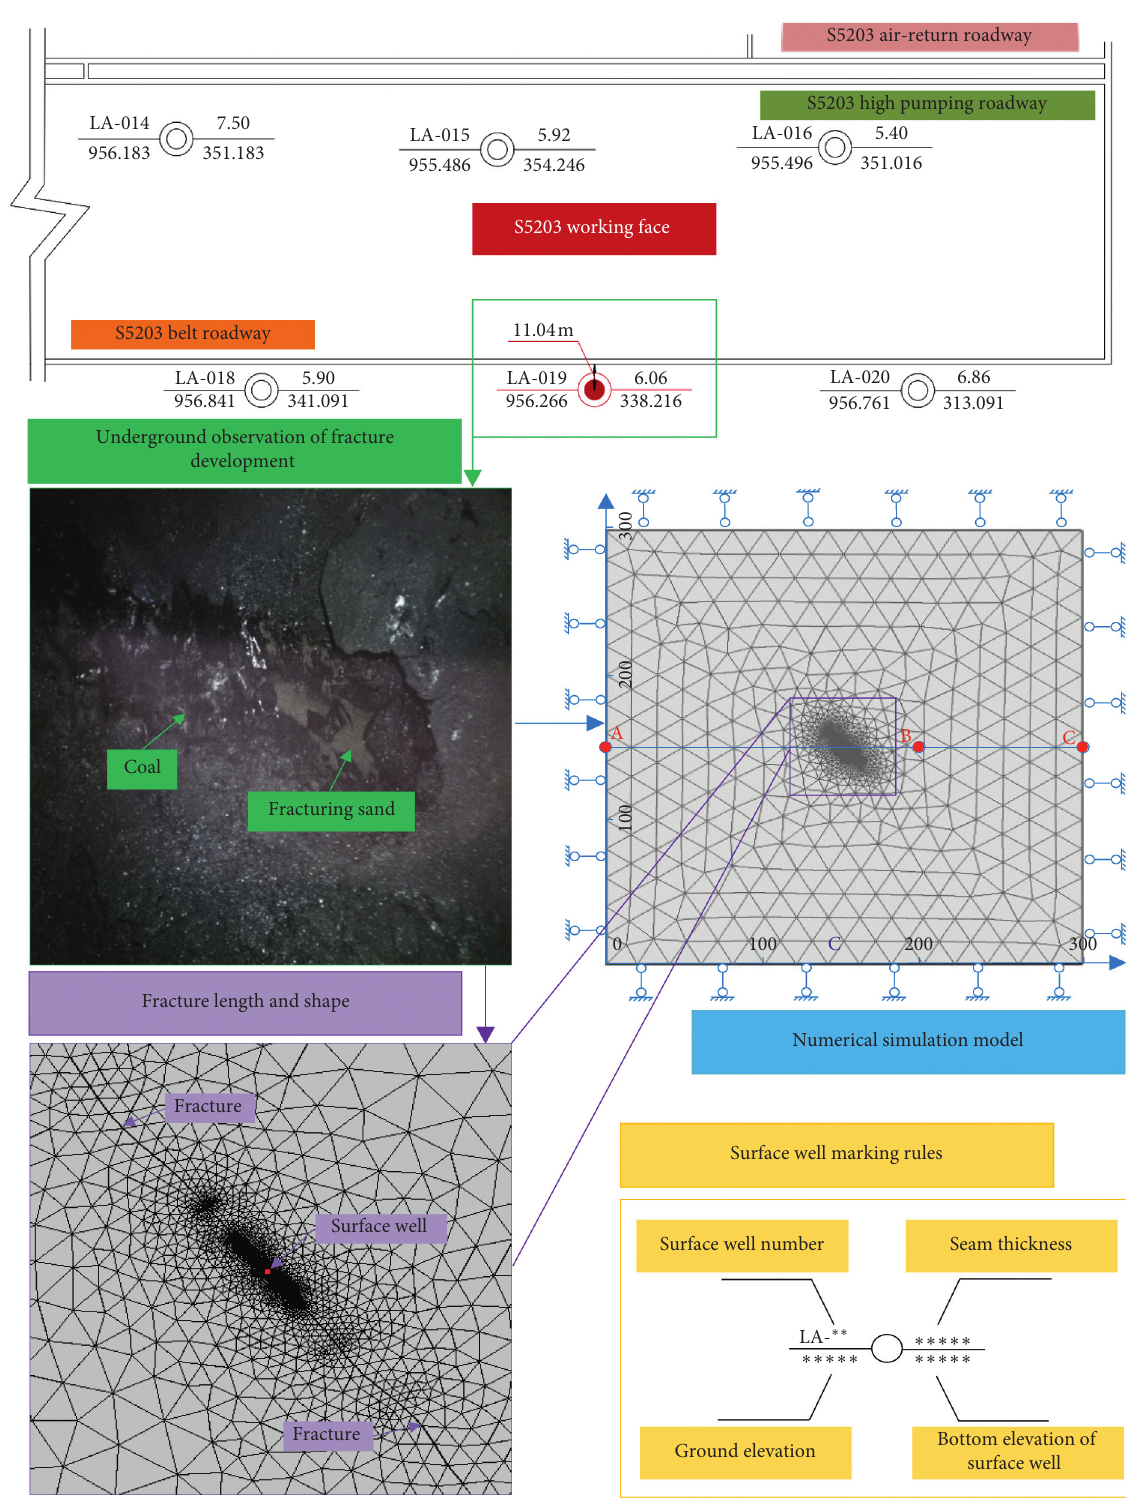
Figure 2: Establishment of numerical simulation